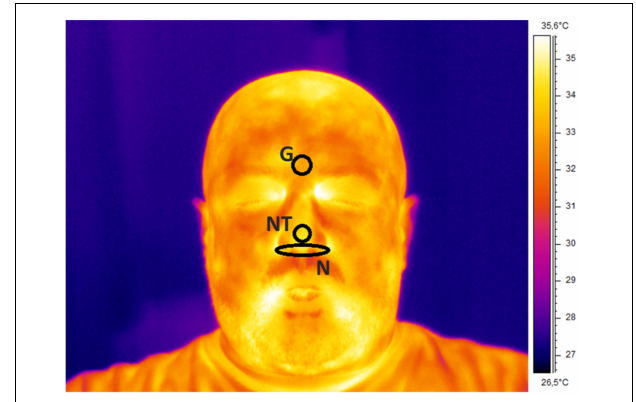
FIGURE 1 | Thermogram of a representative participant with ROIs placement over the glabella (G), nose tip (NT), and nostrils (N). to predict the different HRV metrics [i.e., mean HR (beats/min),